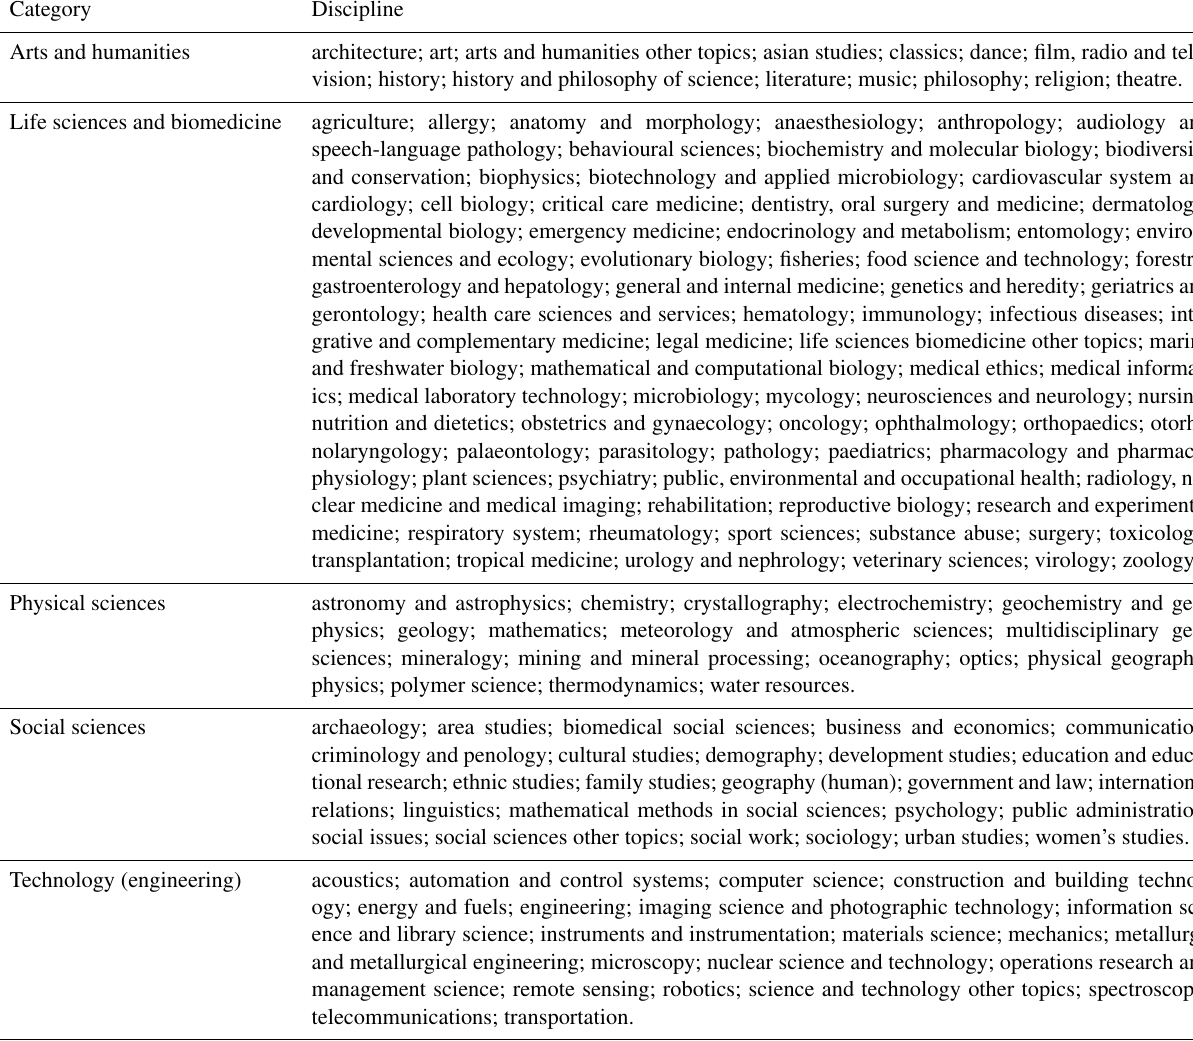
Table A1. Classification of subject categories and